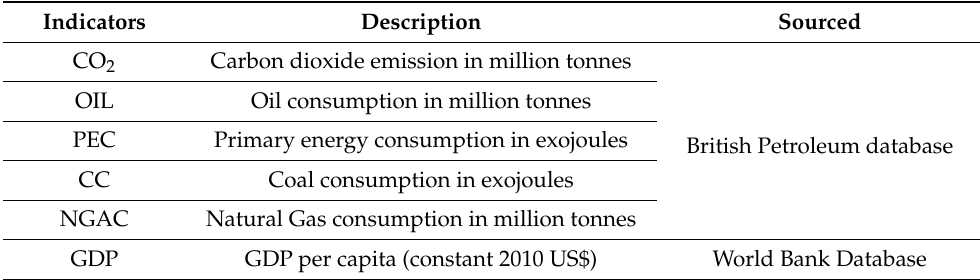
Table 1. Definition of the